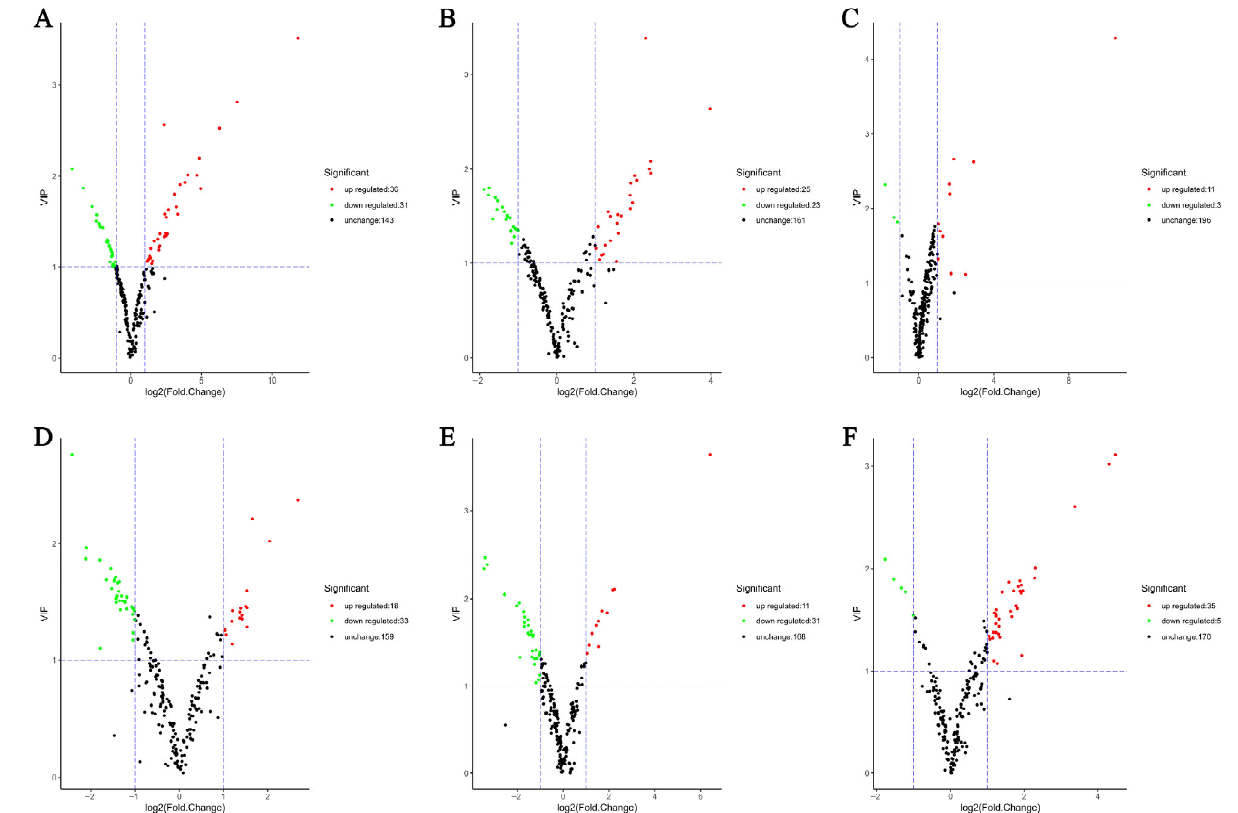
Figure 6. Volcano diagrams of differential metabolites. ( A – F ) Volcano plots of flavonoid differential metabolites of A1 vs. A6, A1 vs. A2, A2 vs. A3, A3 vs. A4, A4 vs. A5, and A5 vs. A6, respectively. Each point on the volcano map represents a metabolite, the abscissa represents the logarithm of the quantitative difference multiple of a metabolite in the two samples, and the ordinate represents the VIP value. The larger the absolute value of the abscissa is, the greater the fold difference of the expression between the two samples is. The larger the ordinate value is, the more significant the differential expression is, and the more reliable the differentially expressed metabolites are. The green dots in the figure represent down ‐ regulated differentially expressed metabolites, while the red dots represent up ‐ regulated differentially expressed metabolites, and the black dots represent detected but not significantly different metabolites.